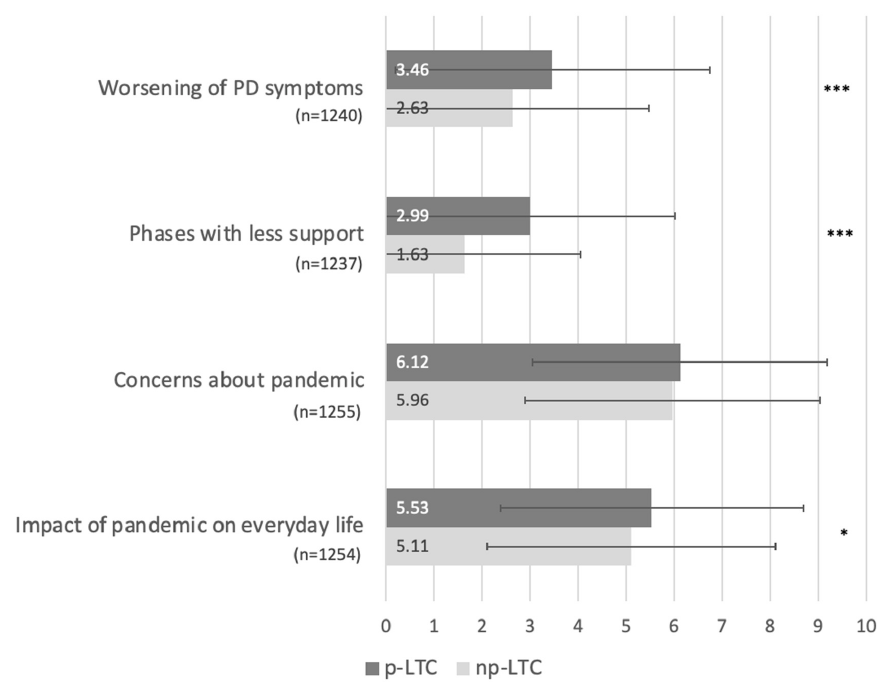
Figure 1. Evaluation of general consequences of COVID-19 pandemic in comparison between p-LTC and np-LTC group. People with Parkinson’s disease (PwP) evaluated the general consequences of the pandemic on everyday life on a visual scale from 0 (not applicable/not at all) to 10 (very applicable/very much). Results are depicted as mean values with standard deviation for both groups (dark grey: PwP with professional long-term care (p-LTC), light grey: PwP without long-term care (np-LTC)). Significant group differences are marked with * (* p < 0.05, *** p < 0.001).